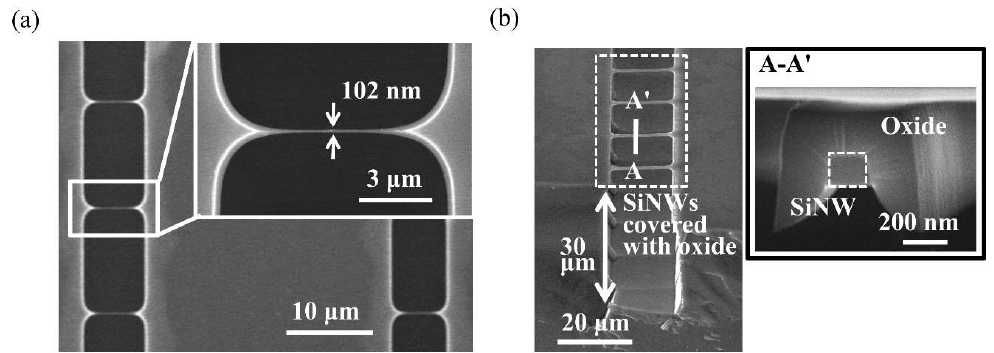
Figure 2. Fabrication results for SiNWs. ( a ) Fabricated SiNW arrays. ( b ) Integration of the suspended SiNWs and two microstructures with a trench depth of 30 μm. SiNW with a dimension of 151 nm × 155 nm is covered with the oxide in the cross-sectional view of A-A′.